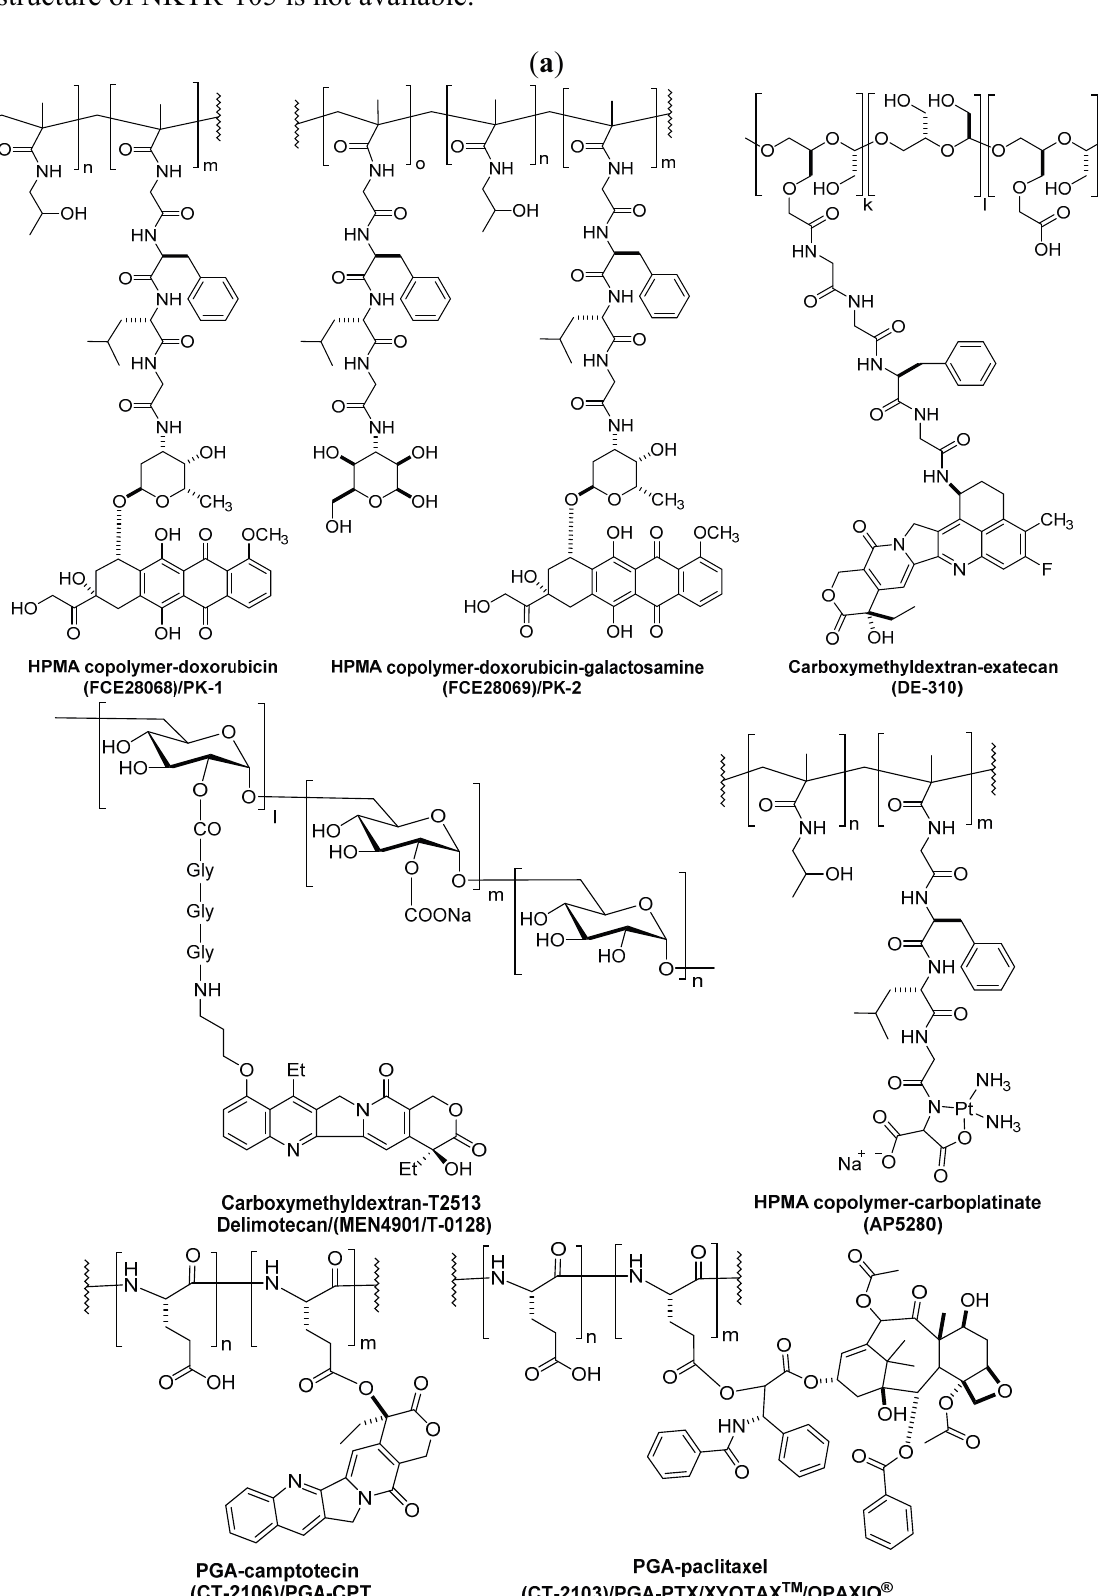
Figure 2. Chemical structures of the PDCs discussed in this article. ( a ) PDCs for which the release of the drug is triggered via an enzymatic mechanism; and ( b ) PDCs for which the release of the drug is triggered by a non-enzymatic mechanism. Note: The chemical structure of NKTR-105 is not